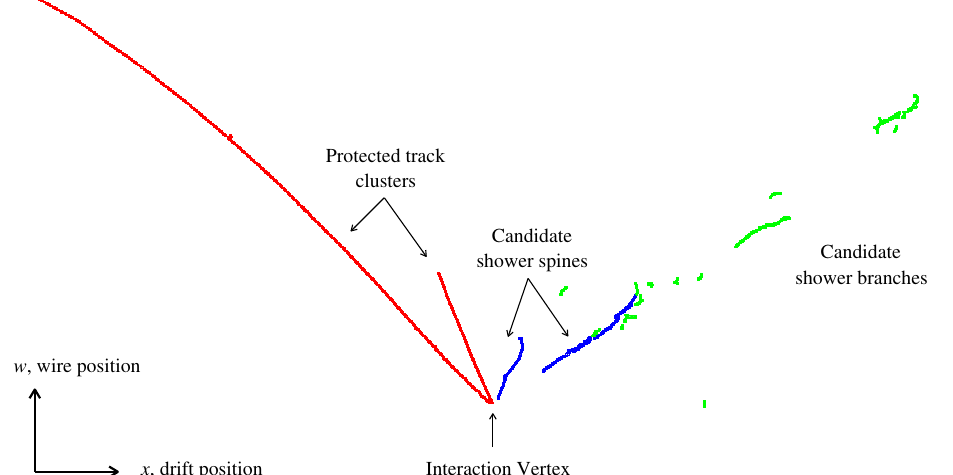
Fig. 7 Cluster labels used by the shower reconstruction algorithms. Clusters identified as track-like (red) are excluded from the shower reconstruction. Long, typically vertex-associated, shower-like clusters (blue) are identified as possible shower spines. The ShowerGrowing